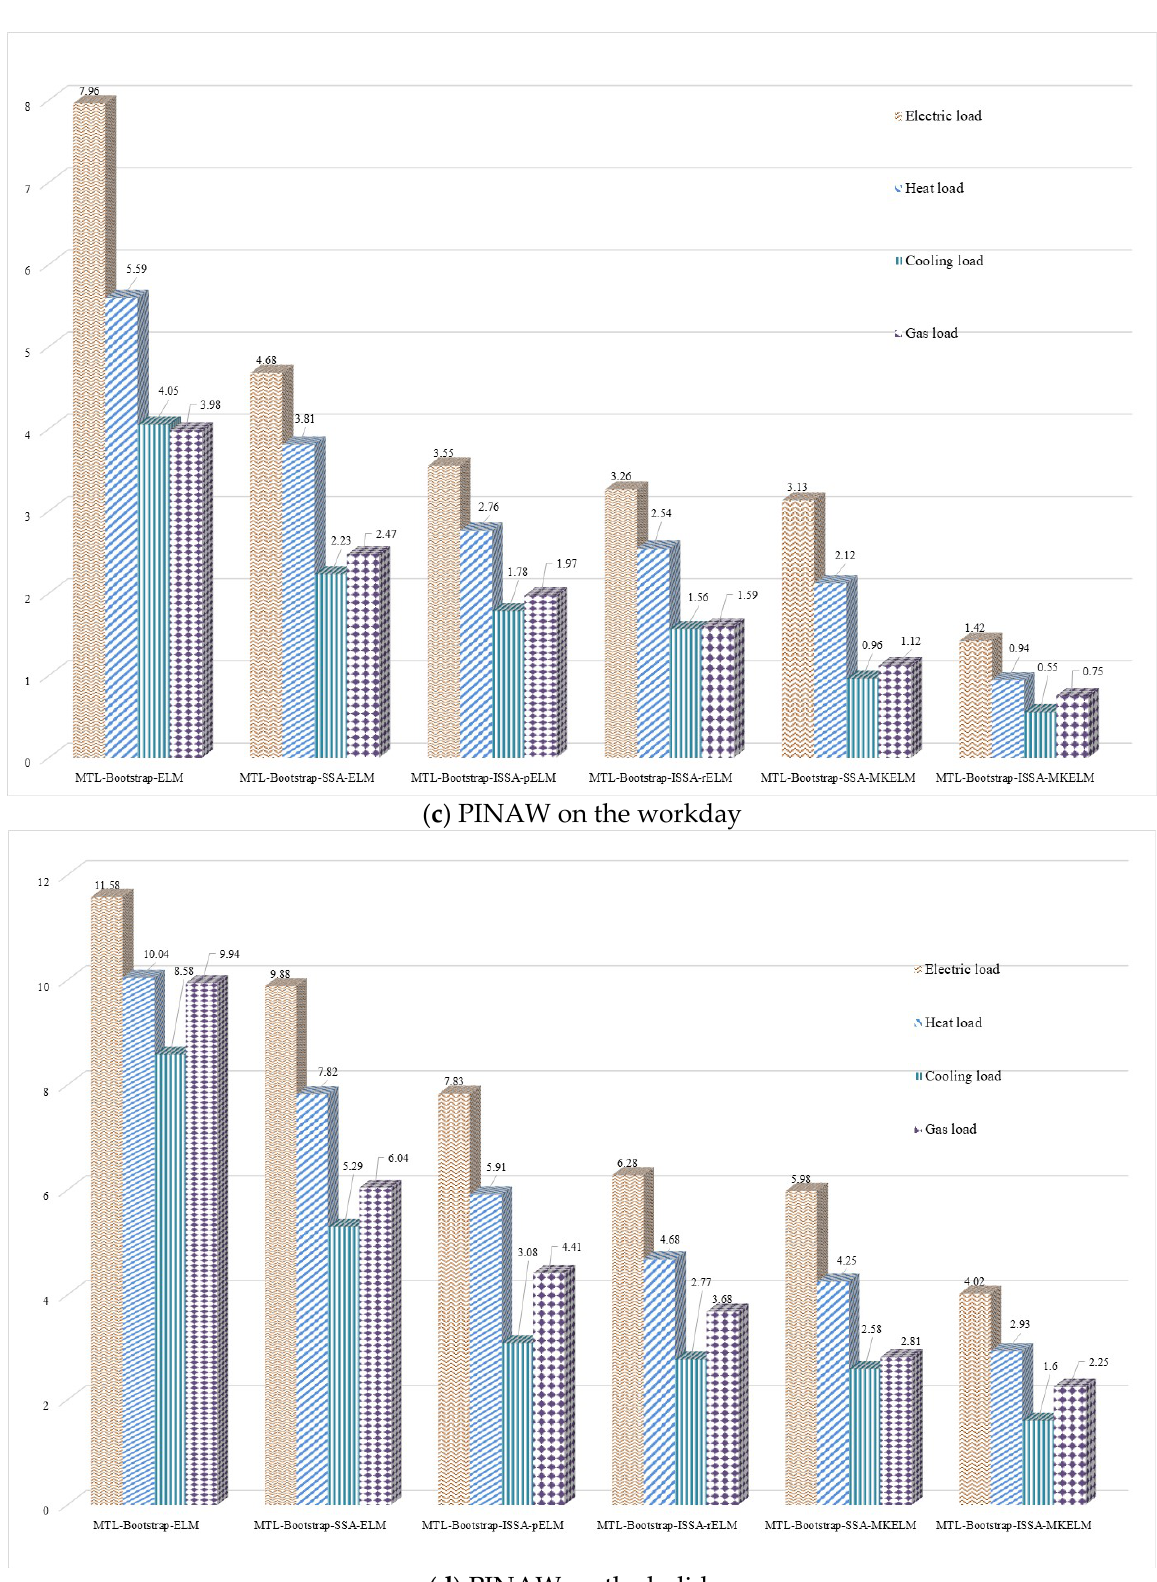
Figure 16. Comparison of PICP and PINAW values of six prediction models.